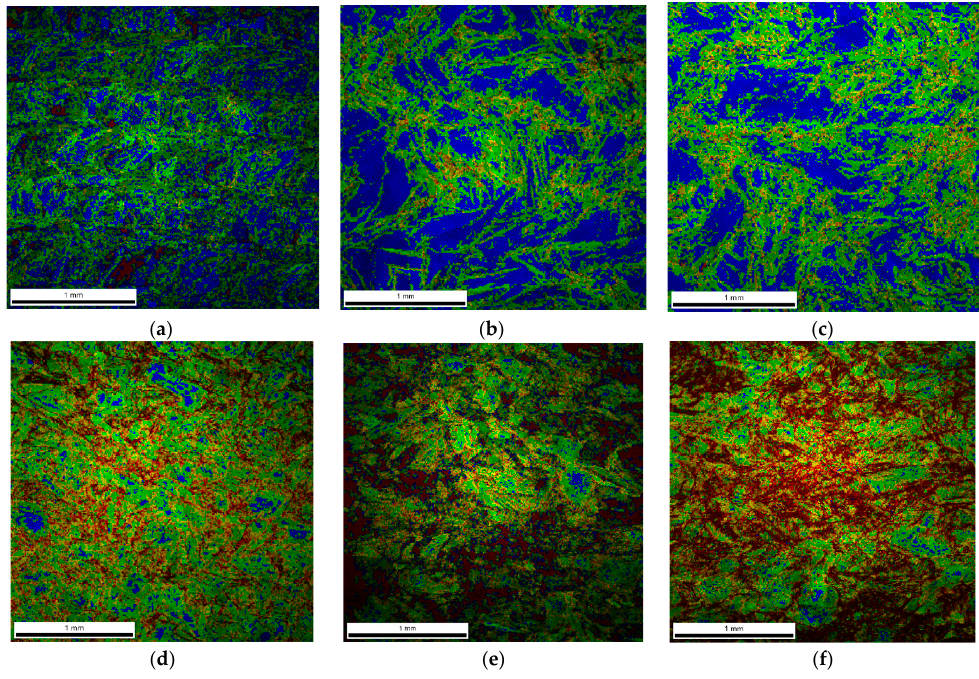
Figure 8. Kernel Average Misorientation (KAM) EBSD maps of samples made of additively manufactured 316L steel subjected to dynamic plastic deformation at various rates: ( a ) not deformed; ( b ) 𝜀 (cid:4662) = 970 s − 1 ; ( c ) 𝜀 (cid:4662) = 1180 s − 1 ; ( d ) 𝜀 (cid:4662) = 1700 s − 1 ; ( e ) 𝜀 (cid:4662) = 2830 s − 1 ; ( f ) 𝜀 (cid:4662) = 4100 s − 1 . Materials 2020 , 13 , x FOR PEER REVIEW